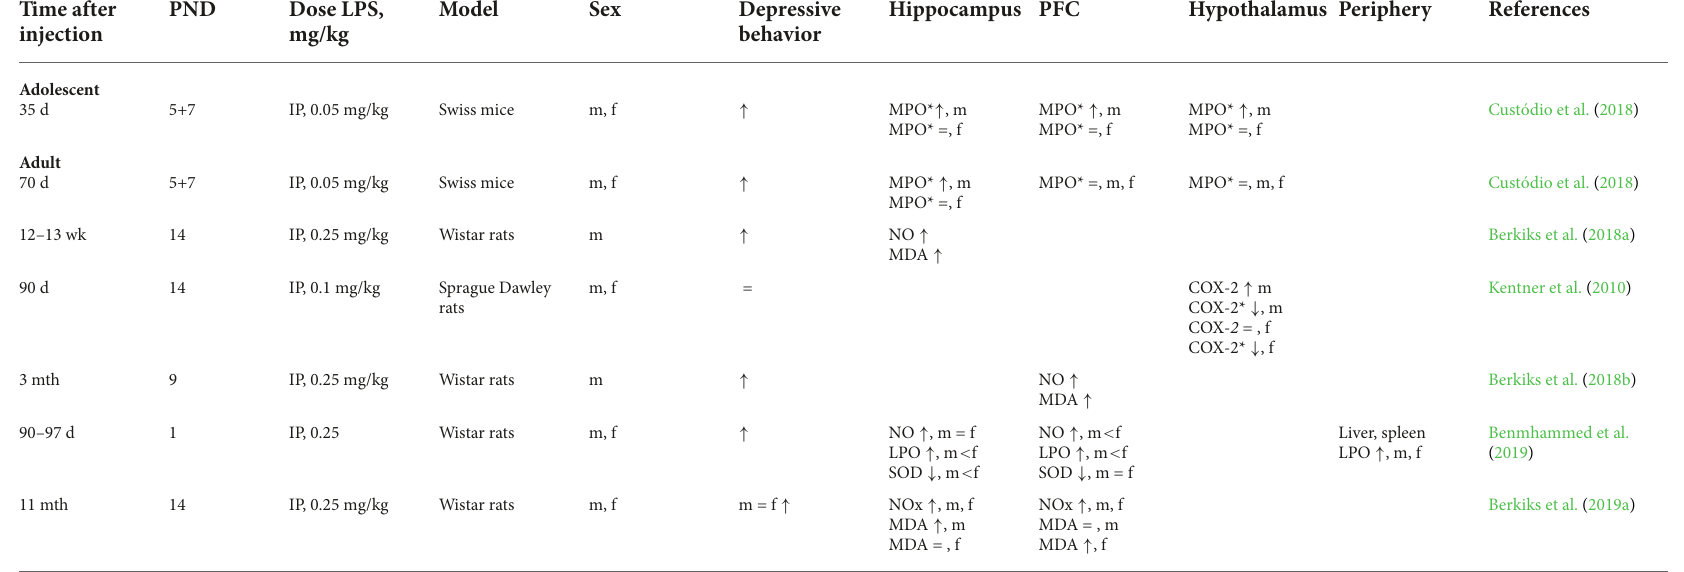
TABLE 3 The influence of NIA on the magnitude of oxidative